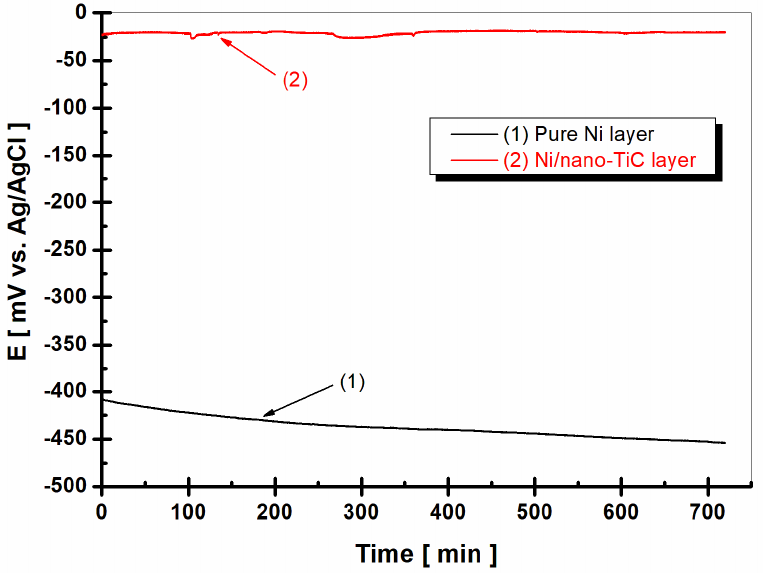
Figure 5. Evolution of the free potential (OCP) over 12 h after 36 h immersion in H 3 BO 3 -LiOH solution: (1) pure Ni layer; (2) Ni/nano-TiC layer.